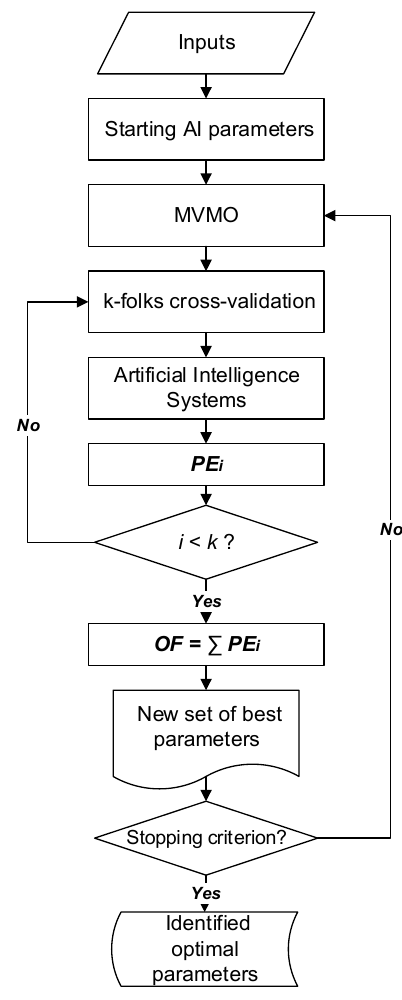
Figure 5. Methodology for identification of Artificial Intelligence AI parameters based on Mean- Figure5. MethodologyforidentificationofArtificialIntelligenceAIparametersbasedonMean-Variance Variance Mapping Optimization (MVMO). Mapping Optimization